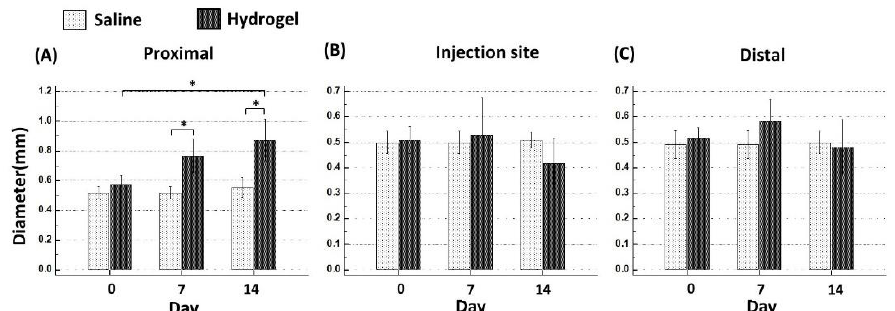
Figure 3. Changes of sciatic nerve diameter at the proximal ( A ), injection site ( B ), and at a distal ( C ) segment at days 7 and 14 (asterisk, p < 0.05).